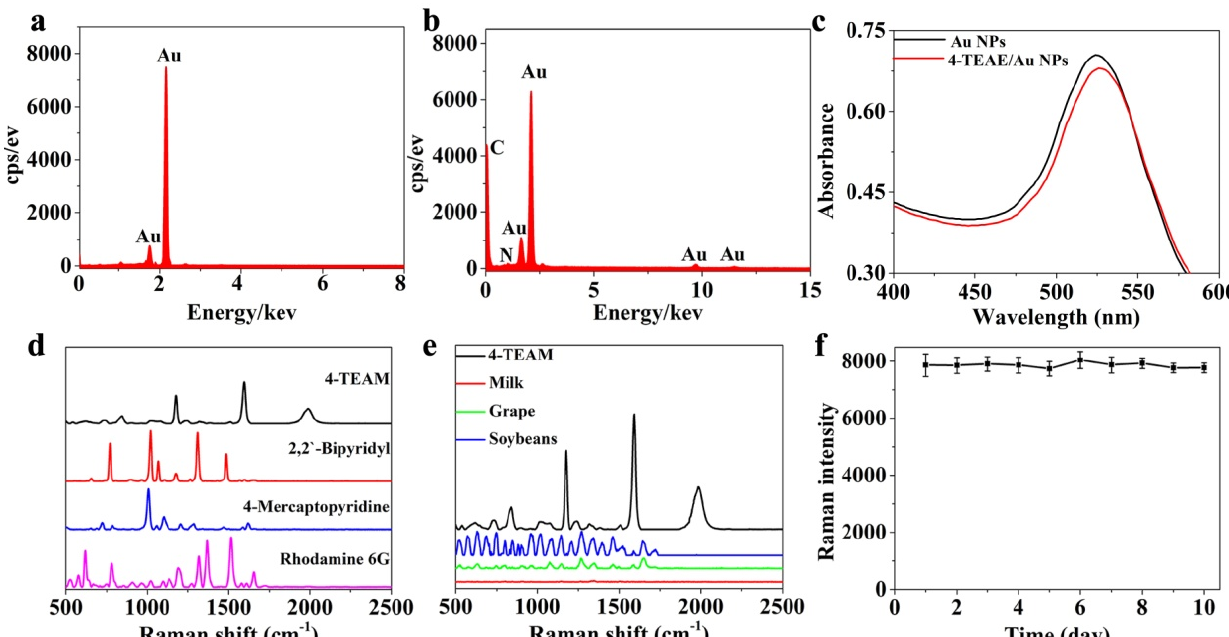
Figure 2. Characterization of the anti-interference SERS tag: ( a ) EDS spectroscopy of Au NPs. ( b ) EDS spectroscopy of 4-TAAE/Au NPs. ( c ) UV − vis spectrum of 4-TEAE/Au NPs (red), Au NPs (black). ( d ) Raman scatterings of conventional RRs and anti-interference SERS probe (black). ( e ) Raman scatterings of food samples and anti-interference SERS tag (black). ( f ) Stability of SERS tag for ten days.